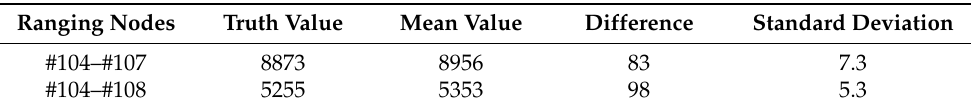
Figure 6. The ranging observations between anchor node 104 and #107/#108. Table 3. Accuracy statistics of ranging experiment (mm).